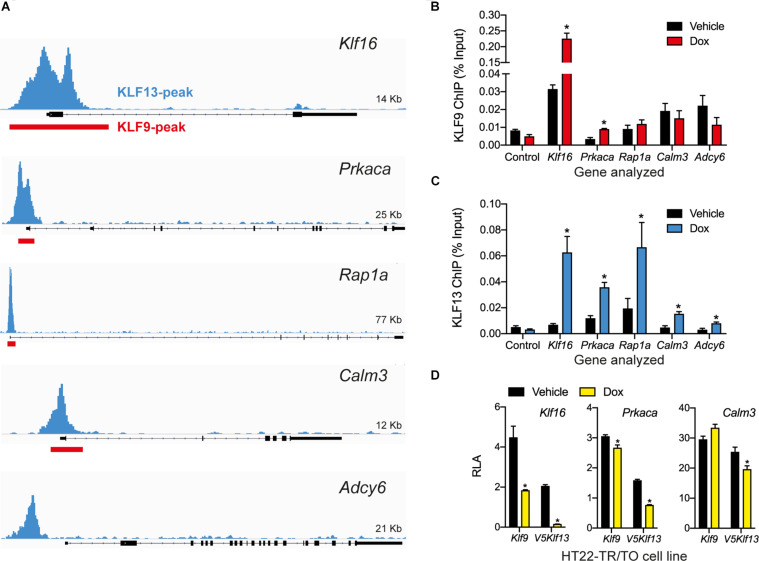
KLF9 and KLF13 associate in chromatin at promoters of cAMP signaling pathway genes in HT22 cells. (A) Screenshots of genome traces from the Integrative Genome Viewer (IGV) showing the locations of KLF13 chromatin-streptavidin precipitation sequencing (ChSP-seq) peaks at genes in the cAMP signaling pathway (Ávila-Mendoza et al., 2020). The gene structures are shown below the genome traces, with lines and black filled bars representing introns and exons, respectively. The gene orientations are 5′ 3′, and all peaks are within the proximal promoter regions of the genes shown. Red boxes indicate locations of KLF9 peaks identified previously by ChSP-seq (Knoedler et al., 2017). (B,C) We conducted targeted ChIP-qPCR assays in HT22 cells to validate the KLF9 and KLF13 ChSP-seq peaks at cAMP signaling pathway genes. We treated HT22-TR/TO-Klf9 and HT22-TR/TO-V5Klf13-1 cells with vehicle or doxycycline (dox; 1 μg/ml) for 16 h, then harvested cells and isolated chromatin for ChIP assays. The KLF9 and KLF13 ChIP qPCR data are expressed as a percentage of the input. We analyzed the Klf16 intron, which did not have KLF9 or KLF13 ChSP peaks, as a negative control region (Control). Bars represent the mean ± SEM (n = 4/treatment), and we used Student’s independent t-test to compare the ChIP values between vehicle and dox treatment within a cell line (asterisks indicate p < 0.05). (B) KLF9 ChIP qPCR assay conducted on chromatin isolated from HT22-TR/TO-Klf9 cells (Klf16: p < 0.0001; Prkaca: p = 0.0024). (C) KLF13 ChIP qPCR assay conducted on chromatin isolated from HT22-TR/TO-V5Klf13-1 cells (Klf16: p = 0.0006; Prkaca: p = 0.0044; Rap1a: p = 0.032; Calm3: p = 0.027; Adcy6: p = 0.048). (D) KLF9 and KLF13 regulate promoter activity in transfection promoter-reporter assays conducted in HT22 cells. We co-transfected HT22-TR/TO-Klf9 or HT22-TR/TO-V5Klf13-1 cells with pRenilla plus firefly luciferase reporter vectors containing genomic DNA fragments corresponding to KLF9 and KLF13 ChSP peaks [shown in (A)] within the promoters of the Klf16 (positive control), Prkaca and Calm3 genes. Twenty hr after transfection we treated cells with vehicle or dox (1 μg/ml) for 16 h, then harvested cells and conducted dual luciferase reporter assay. The relative luciferase activity (RLA) represents firefly luciferase normalized to the Renilla luciferase values. Forced expression of Klf9 or V5Klf13 repressed transcriptional activity of the Klf16 and Prkaca promoters (HT22-TR/TO-Klf9: Klf16, p = 0.0004; Prkaca, p = 0.018; HT22-TR/TO-V5Klf13-1: Klf16, p < 0.0001; Prkaca, p < 0.0001; n = 4/treatment; Student’s independent t-test); only forced expression of V5Klf13 repressed transcriptional activity of the Calm3 promoter (Calm3, p < 0.013; n = 4/treatment). Asterisks indicate statistically significant differences within a cell line with p < 0.05.